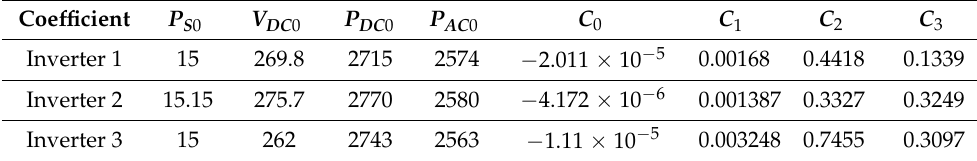
Table 6. Empirically identified parameters used to predict AC power using sandia inverter model.